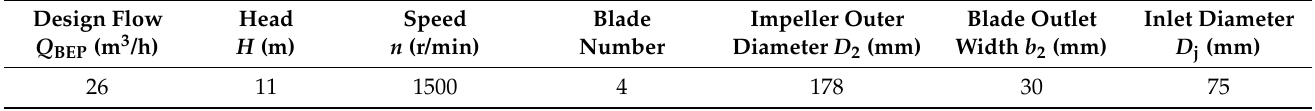
Table 1. Main parameters of 25 MZ slurry